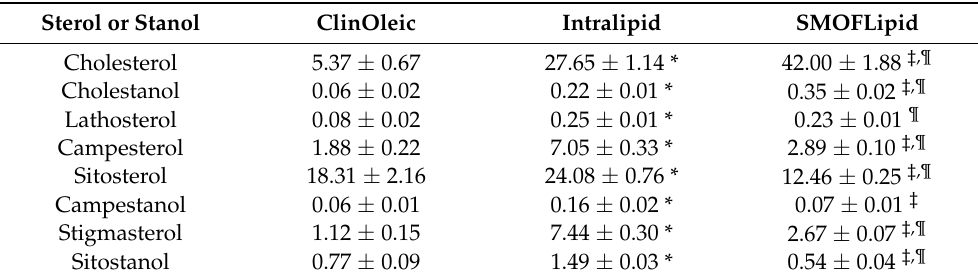
Table 2. Sterol and stanol concentrations (mg/dL) in the three lipid emulsions. Data are mean ± SD from three replicates. Sterol or Stanol